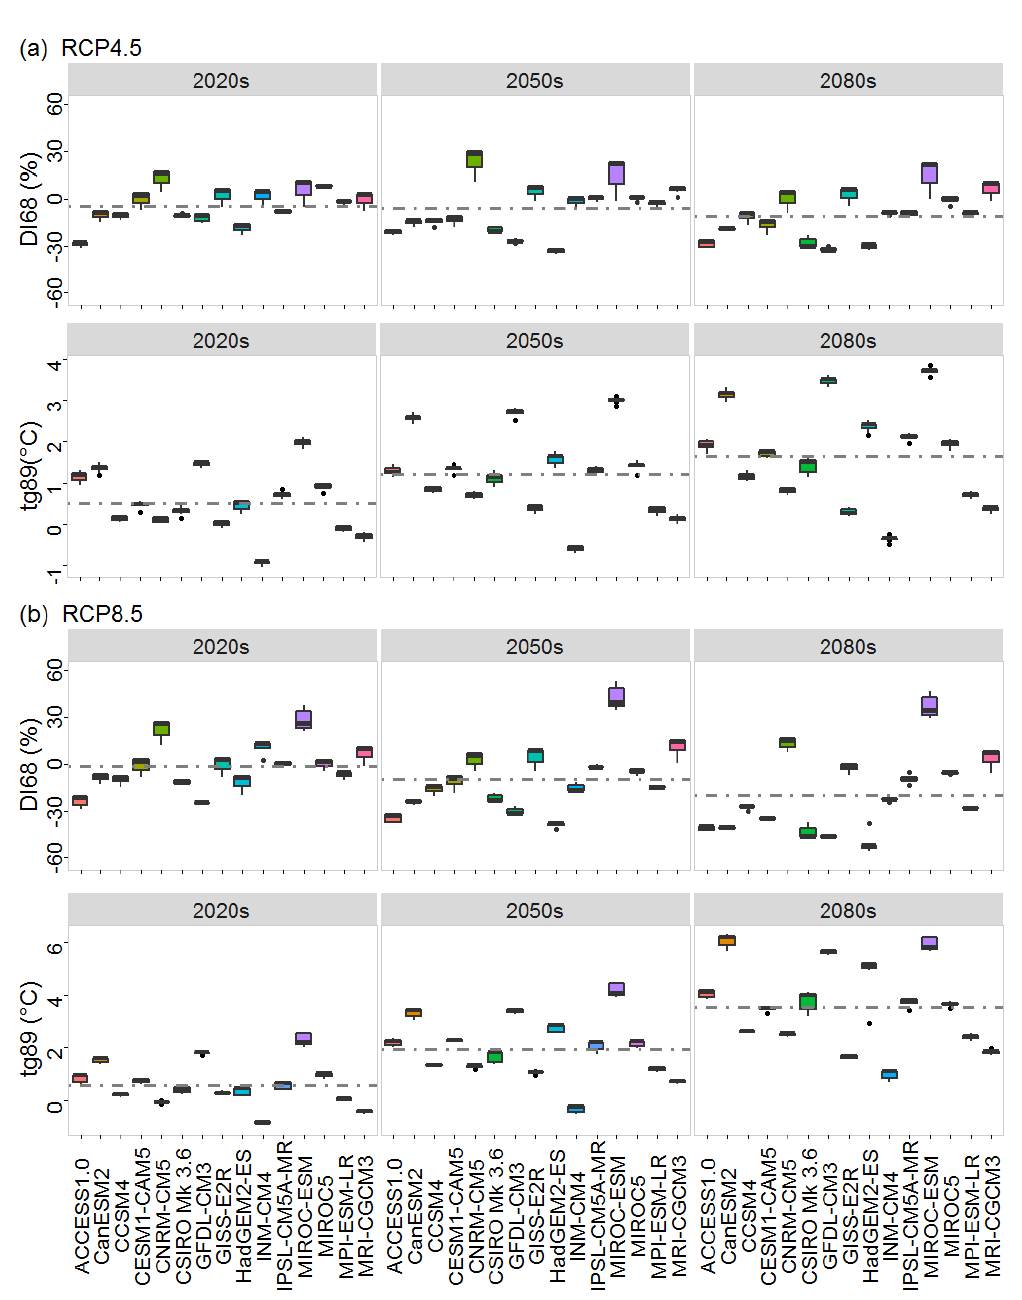
Figure 4. Future summer drought index ( DI 68, cumulated drought index from June to August) and autumn temperature ( tg 89, average temperature for August and September) relative to 1991–2009 considering the emission scenario RCP4.5 ( a ) and RCP8.5 ( b ). Each box indicates the climate changes compared to the reference period for the 14 Norway spruce plantation stands (dataset 1) in west Denmark (mean, one standard deviation, and minimum to maximum range) are given for the periods 2020s (2011–2040), 2050s (2041–2070) and 2080s (2071–2100) for 15 Global Climate Models (AOGCMs) of the CMIP5 multi-model (i.e., ACCESS1.0, CanESM2, CCSM4, CESM1-CAM5, etc.). The grey dashed horizontal line indicates the mean value of the 15 Global Climate Models.